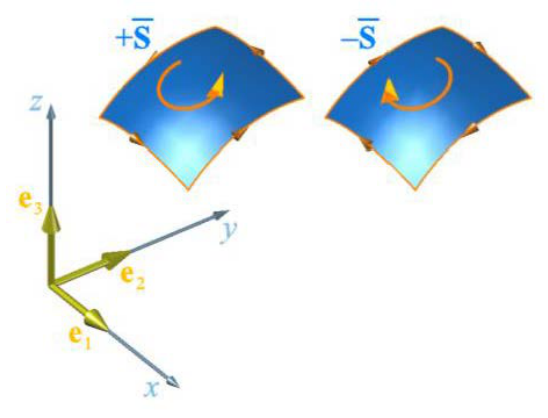
Figure 18: Positive and negative inner orientations of a surface.